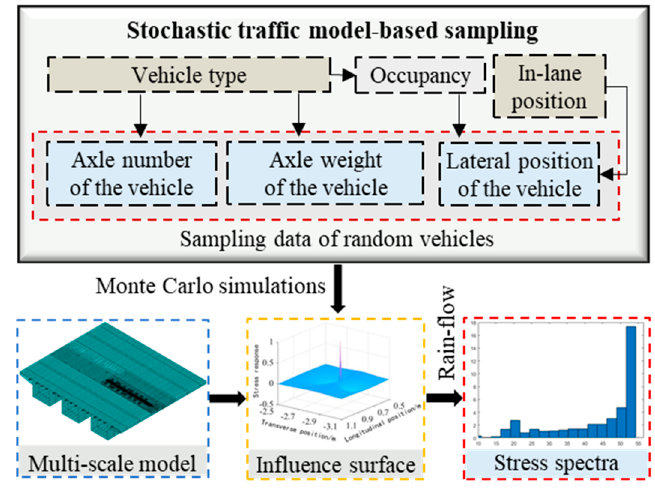
Figure 13. Derivation of stress spectra using Monte Carlo simulations.